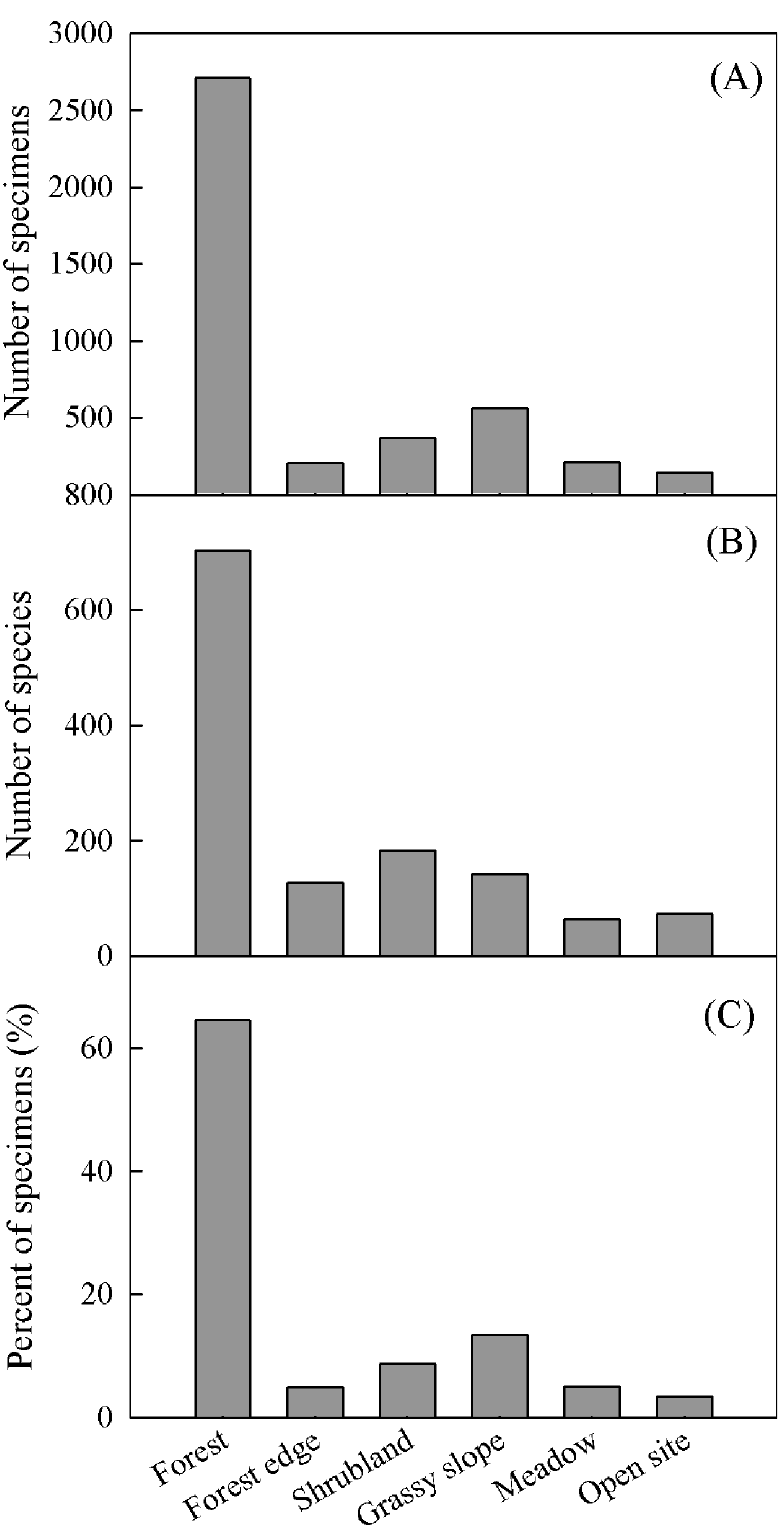
Fig 2. Distribution of orchid specimens (A) and species (B), and proportion of specimens occurring in different habitats (C).